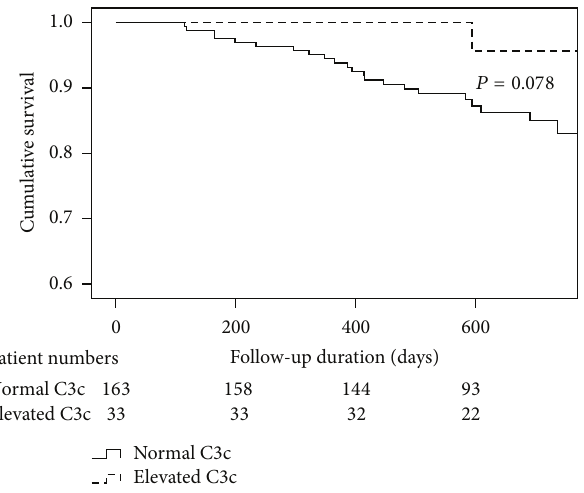
Figure 3: Kaplan-Meier estimates all-cause mortality risk by C3c values. Mortality risk tended to be increased in the group with normal ( 𝑛 = 163 ) C3c values compared to subjects with elevated ( 𝑛 = 33 ) C3c values (log rank test, 𝑃 = 0.078